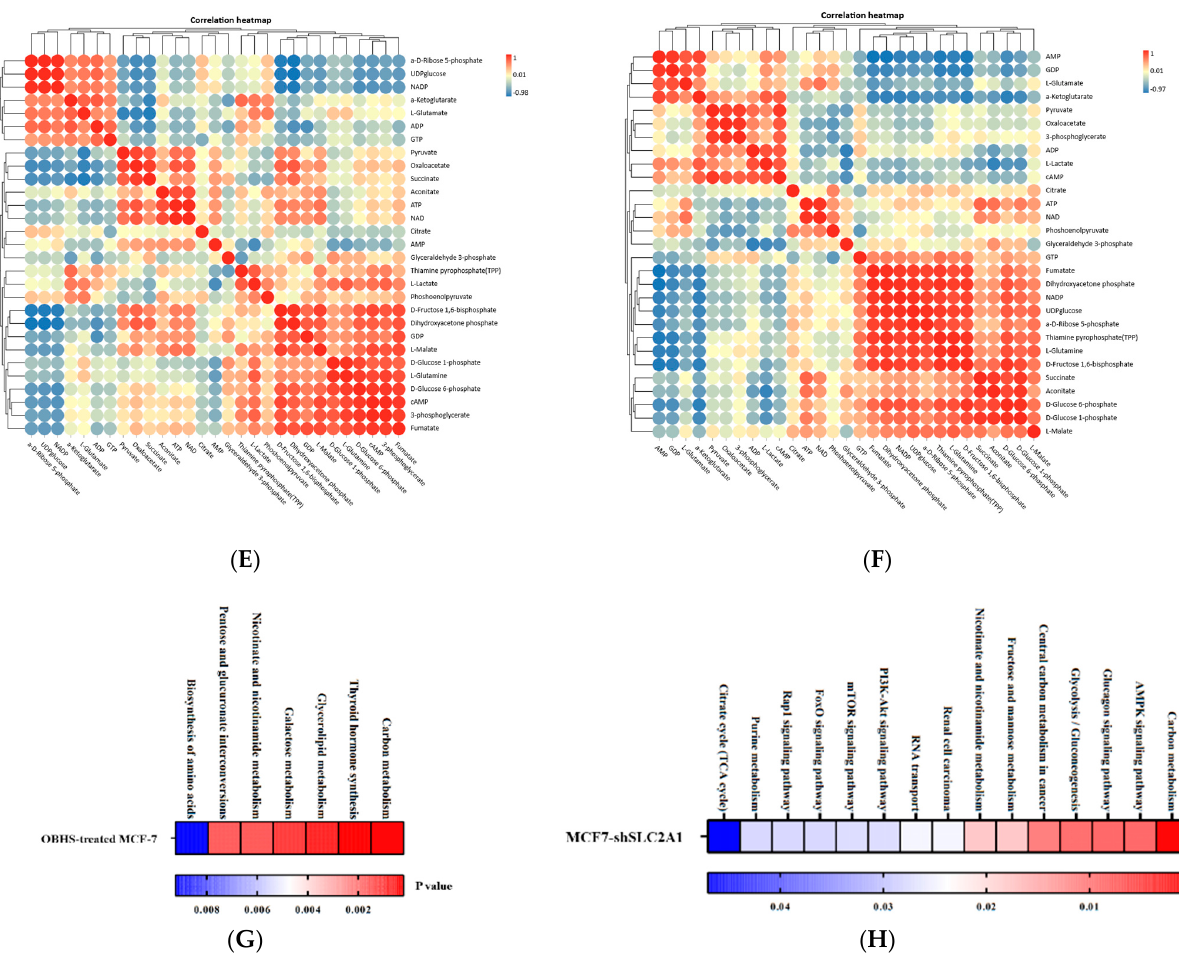
Figure 3. OBHS was crucial for the GLUT1-dependent reprogramming mechanism in the energy metabolism pathway. The y -axis indicates the metabolites, and the x -axis indicates the fold change of the metabolites in ( A ) OBHS-treated (red triangles) and SLC2A1 knockdown (yellow triangles) MCF-7 cells. ( B ) PCA score plots of OBHS-treated (red triangles) and SLC2A1 knockdown (yellow triangles) MCF-7 cells samples. Heat map and hierarchical clustering of metabolites in ( C ) OBHS-treated and ( D ) MCF7-sh SLC2A1 cells and controls. Fold change > 0 represents upregulated metabolites, which are shown in red. Fold change < 0 represents downregulated metabolites, which are shown in blue. Heat map of the correlation coefficient matrix shows the ratio of correlation coefficients of 40 metabolites from the data in ( E ) OBHS-treated and ( F ) sh SLC2A cells. Pearson R is between − 1 and +1. The correlation coefficient R between metabolites is represented by color and circles, where R > 0 represents a positive correlation and is represented in red. R < 0 represents negative correlation, which is shown in blue. Heat maps generated from the targeted metabolomics array depicting p values for the most highly up- and downregulated metabolites following ( G ) OBHS treatment or ( H ) SLC2A1 knockdown. * p < 0.05 versus control; ** p < 0.01 versus control; *** p < 0.001 versus control; **** p < 0.0001 versus control.